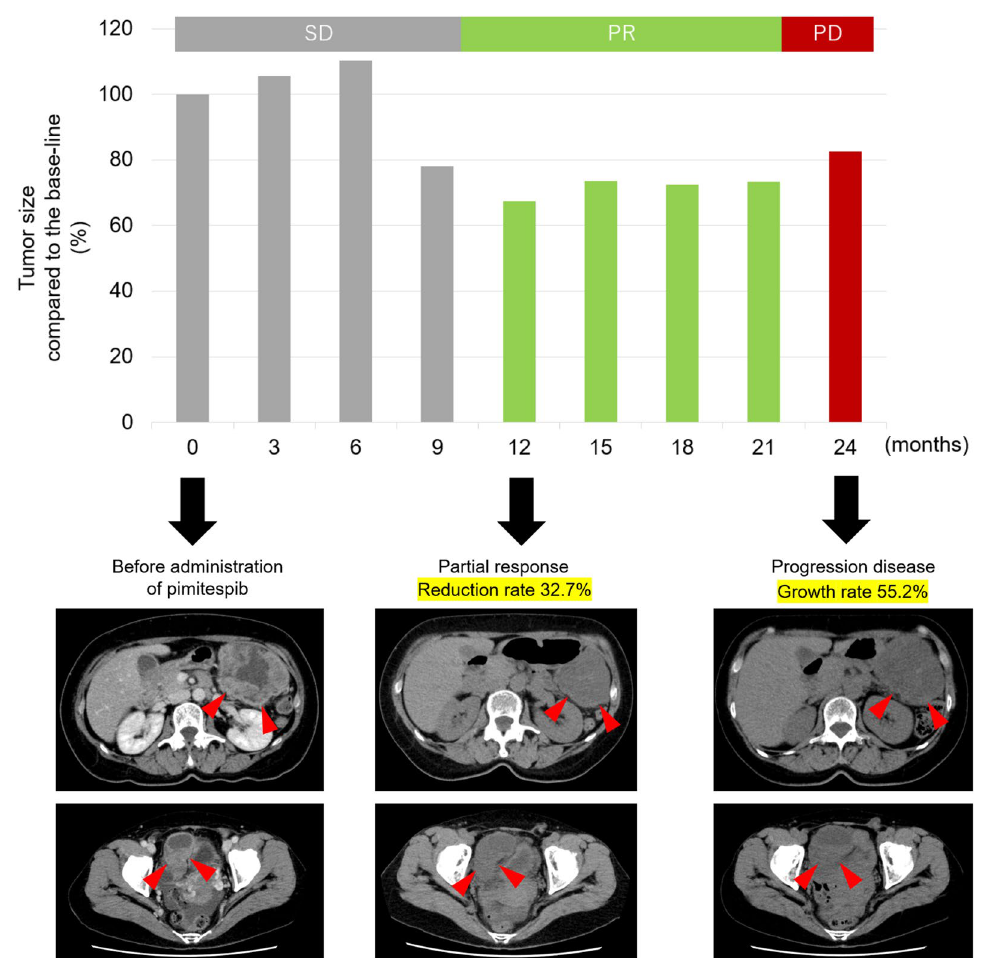
Fig. 3 Detail of effect during treatment with PIMI. Tumor effects are based on response evaluation criteria in solid tumors ver 1.1. PIMI pimitespib. Red arrowheads: recurrent peritoneal GISTs in the upper right abdomen and pelvic